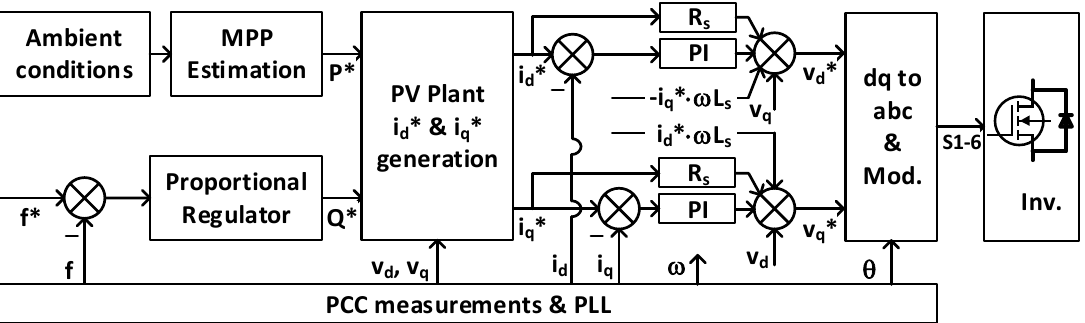
Figure 2. Ancillary service implemented in photovoltaic (PV) system.